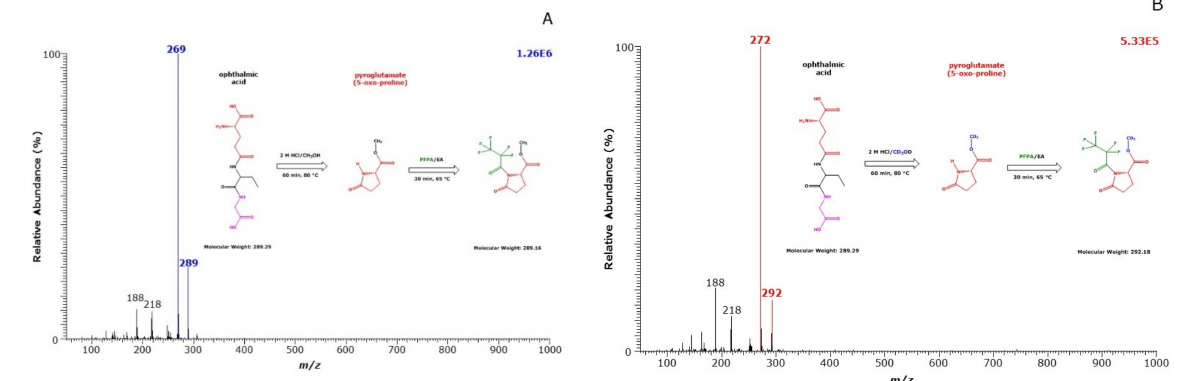
Figure 4. ECNICI mass spectra of the GC-MS peaks obtained from the derivatization of synthetic OPH (each 10 nmol) after its esterification (20 min, 80 ◦ C) in 2 M HCl/CH 3 OH (A) or in 2 M HCl/CD 3 OD, and subsequent acylation with PFPA in ethyl acetate (EA) (30 min, 65 ◦ C). The retention times of the derivatives were 8.43 min ( A ) and 8.41 min ( B ), using TP#2. The quadrupole was scanned in the m / z -range 80–1000 (1 scan/s). Inserts indicate the chemical structure of OPH, the derivatization conditions and the proposed structures of the methyl ester and pentafluoropropionyl